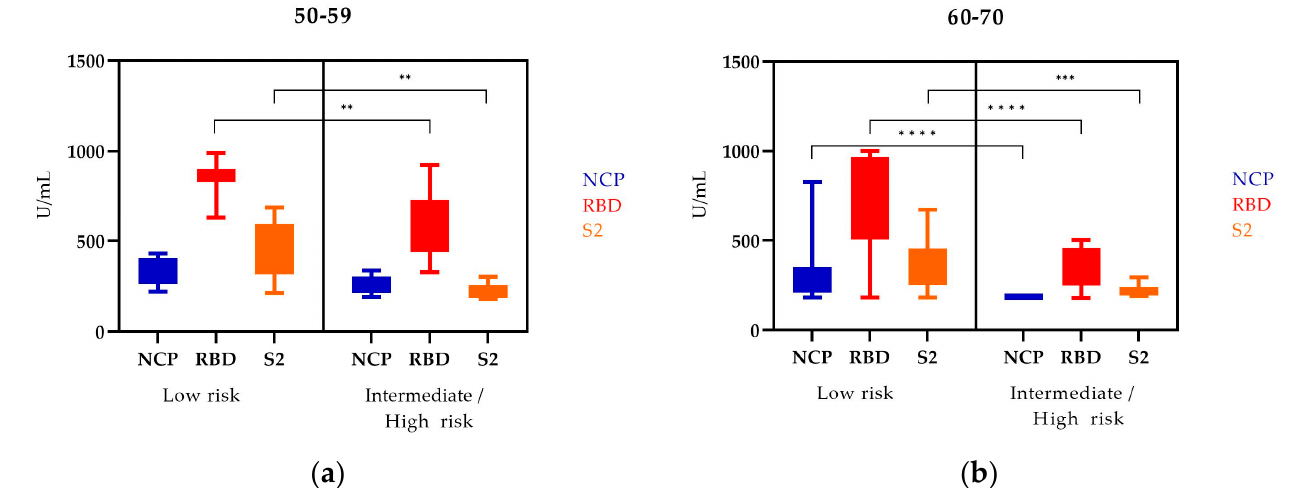
Figure 3. NCP, RBD, and S2 IgG antibody levels in PCa patients depending on age in two risk groups (the EAU risk groups): ( a ) 50–59, ( b ) 60–70; Mann–Whitney U test; median (min–max); ** statistically significant (10 − 2 ); *** statistically significant (10 − 3 ); **** statistically significant (10 − 4 ).